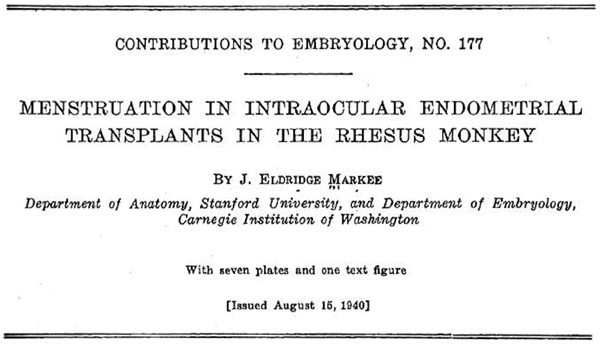
The innovative studies of Markee that used intraocular implants of endometrium in the rhesus monkey to study menstruation [11]. This work began in 1928 and was completed in 1938.